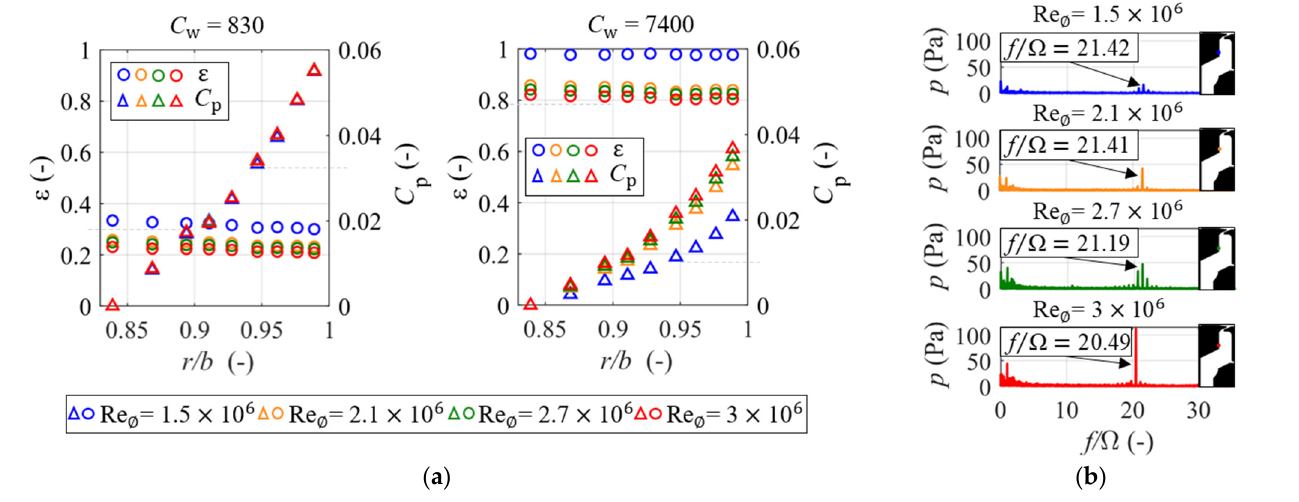
Figure 5. ( a ) Sealing effectiveness and pressure coefficient radial distributions at different Re ∅ for s c = 0.0078 and ( b ) frequency spectra at r/b = 0.95 for C w = 3500 and s c = 0.0042.